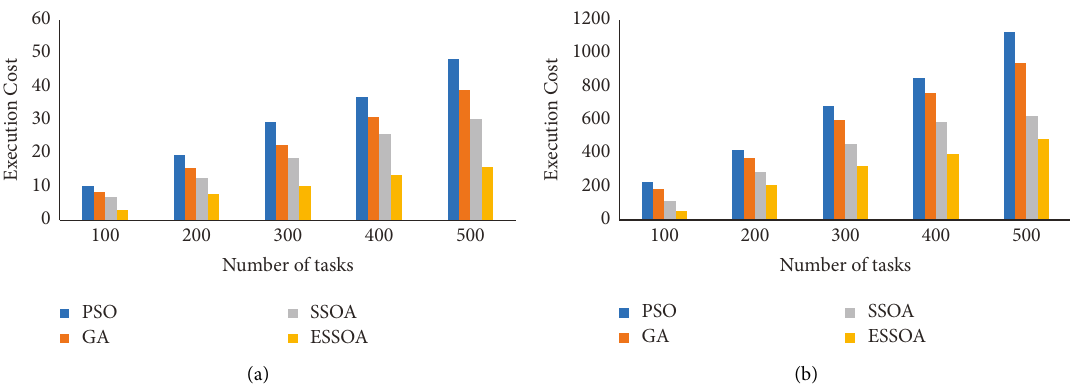
Figure 4: Execution cost of the proposed and existing techniques. (a) Execution cost using Google Cluster and (b) execution cost using PlanetLab.